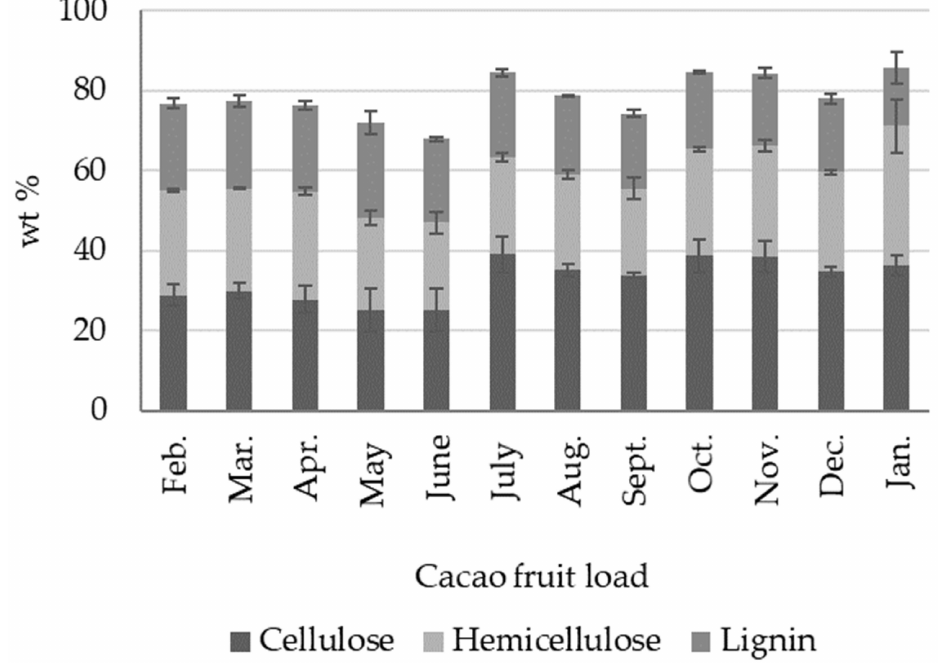
Figure 6. Seasonal variations in structural carbohydrates (cellulose and hemicellulose) and lignin content in CH as fractions of the total solids in fresh CH, from Colombian CCN51 cacao